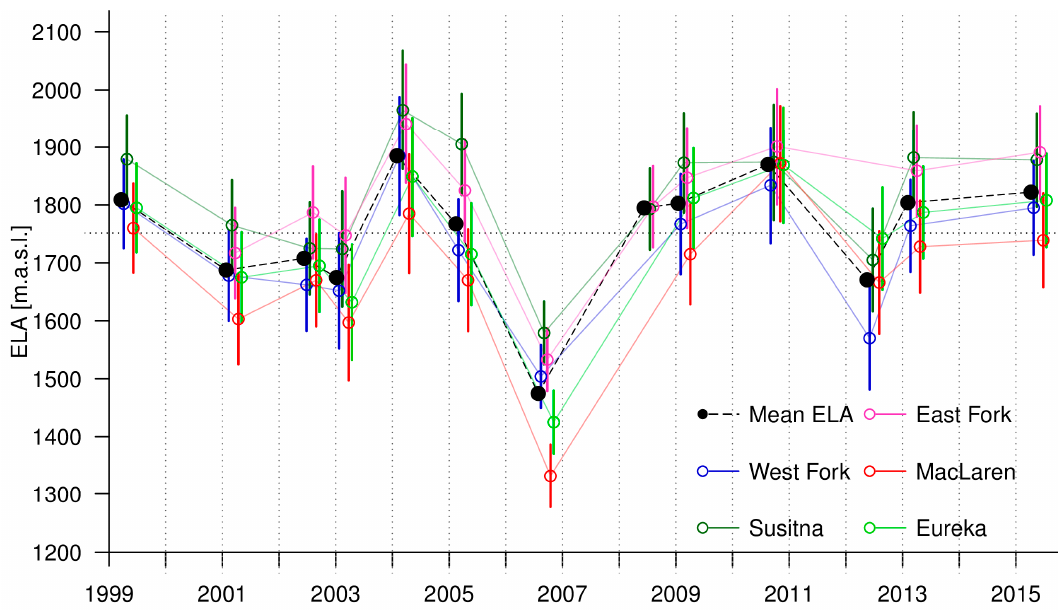
Figure 6. Time series (1999–2015) of annual ELAs for the five largest glaciers. The mean ELA refers to the average of the five glaciers’ annual ELAs. Vertical lines show the uncertainties. For each year, the x-axis refers to the period 1 August to 15 October. For the year 2003, the date was set to 1 August, which lies in between the acquisition date of the two Landsat scenes that were used. The mean ELA of all glaciers (black dots) is positioned to coincide with the date, which the ELA refers to, while for better readability each individual glacier’s ELA is slightly offset. The black dotted line marks the time-averaged ELA of the five large glaciers (1761 m a.s.l.).